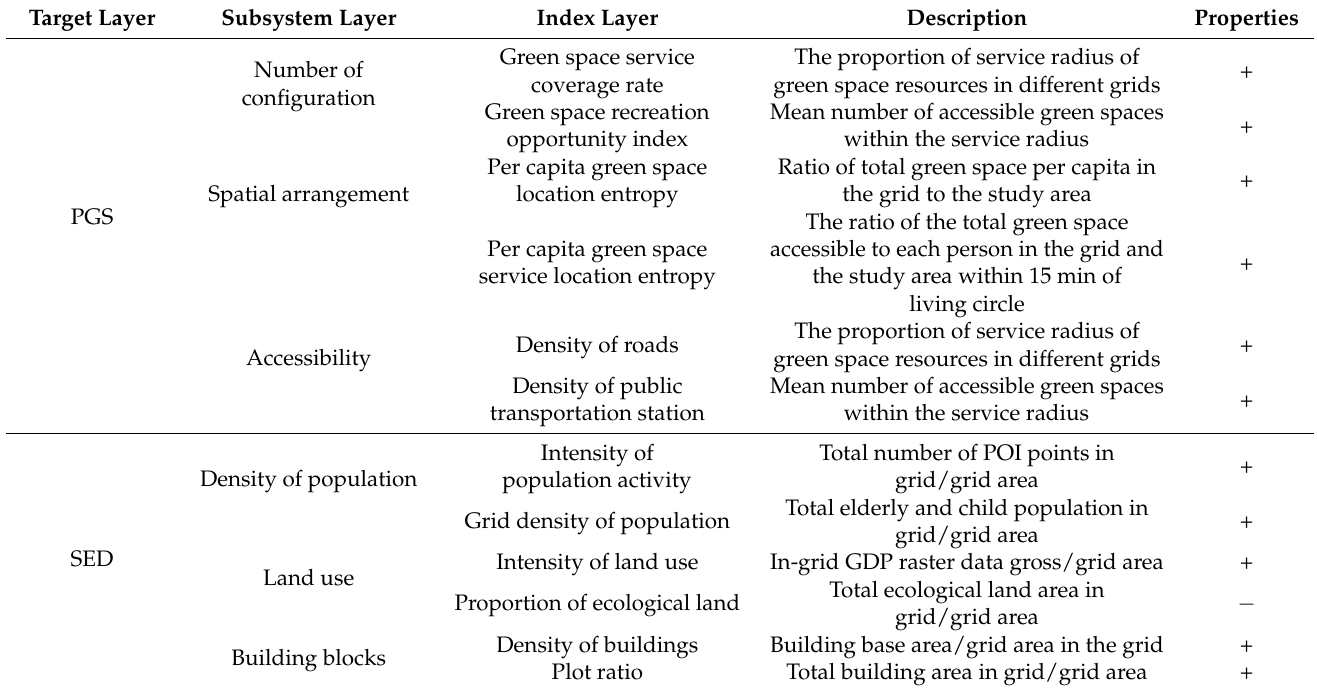
Table 2. Subsystems and indexes of PGS and